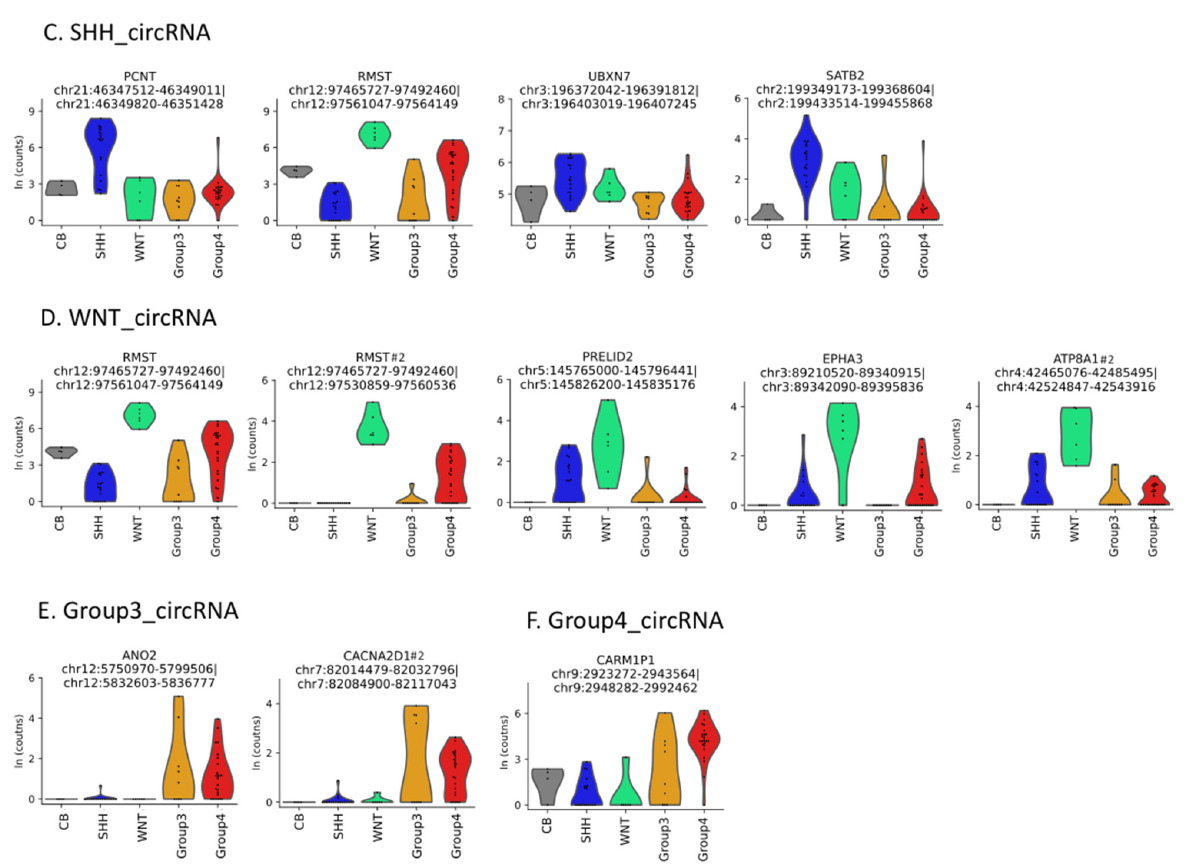
Figure 1. Differentially expressed circular RNAs in human medulloblastoma and normal cerebellum. ( A ) Volcano plots of the RNA-seq data of the SHH, WNT, Group 3 and Group 4 medulloblastoma tumor and normal cerebellum samples. Cutoff thresholds are assessed with the DESeq2 method, where the Wald significance test is applied as |log2 fold change| > 1, padj < 0.05. Annotated are selected circular RNAs defined as the top 5 with highest normalized mean count across samples, the top 5 with lowest padj value, the top 5 with highest log2 fold change and the top 5 with lowest log2 fold change. ( B ) Venn diagrams depicting uniquely and commonly up- and down-regulated circular RNAs (circRNA) in SHH, WNT, Group 3 and Group 4 medulloblastoma subtypes compared to normal cerebellum. ( C – E ) Violin plots of the expression of uniquely up- or down-regulated circular RNAs (circRNA) in the SHH ( C ), WNT ( D ), Group 3 ( E ) and Group 4 ( F ) medulloblastomas that are also annotated as selected circular RNAs in ( A ).